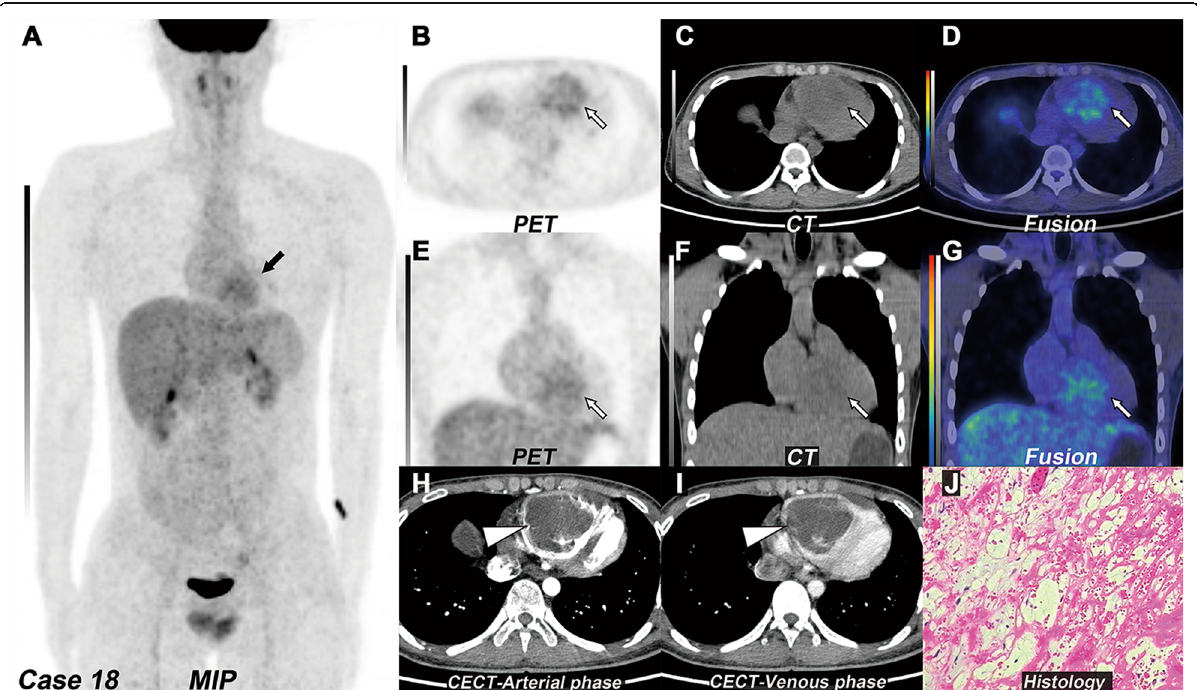
Fig. 4 Right ventricular myxoma. a MIP of 18 F-FDG PET/CT revealed a lesion with increased 18 F-FDG uptake in the heart region (black arrow). b – d The transverse and e – g coronal view of selected PET, CT, and fused PET/CT images revealed a big mass with increased 18 F-FDG uptake (white arrow, SUVmax 4.1), which located in the right ventricle. c and f On the non-contrast CT, the tumor presented homogeneous hypodensity, which was lower than the blood pool. h and i The transverse view of arterial and venous phases of CECT images revealed a huge filling defect in the right ventricle with mild enhancement in the venous phase (white arrowhead). j The histopathology revealed myxoma (H&E, magnification, ×